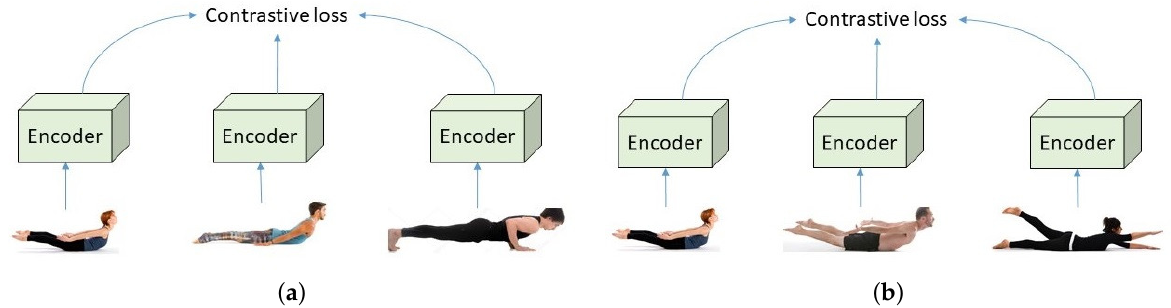
Figure 2. A comparison between ( a ) the coarse triplet example and ( b ) the fine triplet example . The coarse triplet example consists of one anchor from Salabhasana , one positive example from Salabhasana , and one negative example from a different category such as Chaturanga Dandasana . The fine triplet example consists of three examples from the same category such as Salabhasana ; however, they have different pose grades: high -quality, medium -quality, low -quality (for the images from the left to the right,